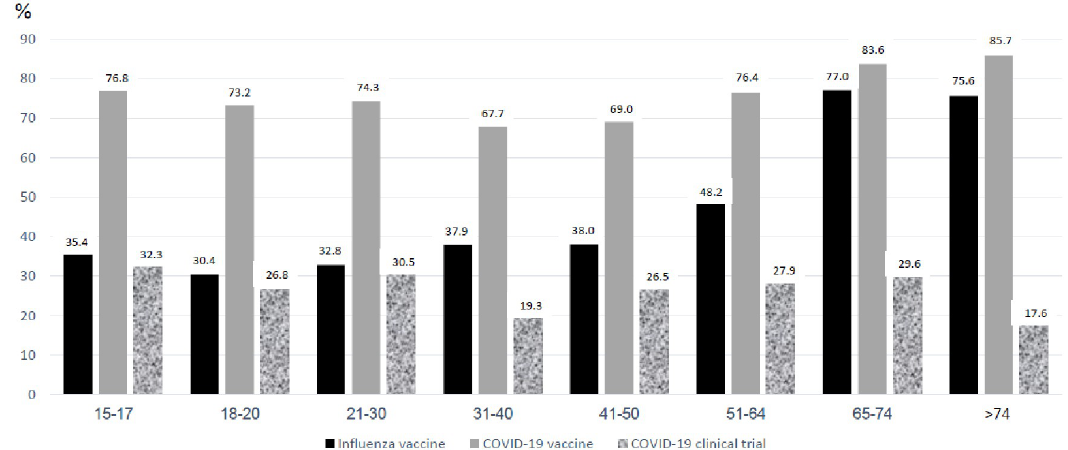
Fig 1. Relation between age and willingness to receive influenza vaccine this coming fall (2020–2021) and COVID-19 vaccine when available.